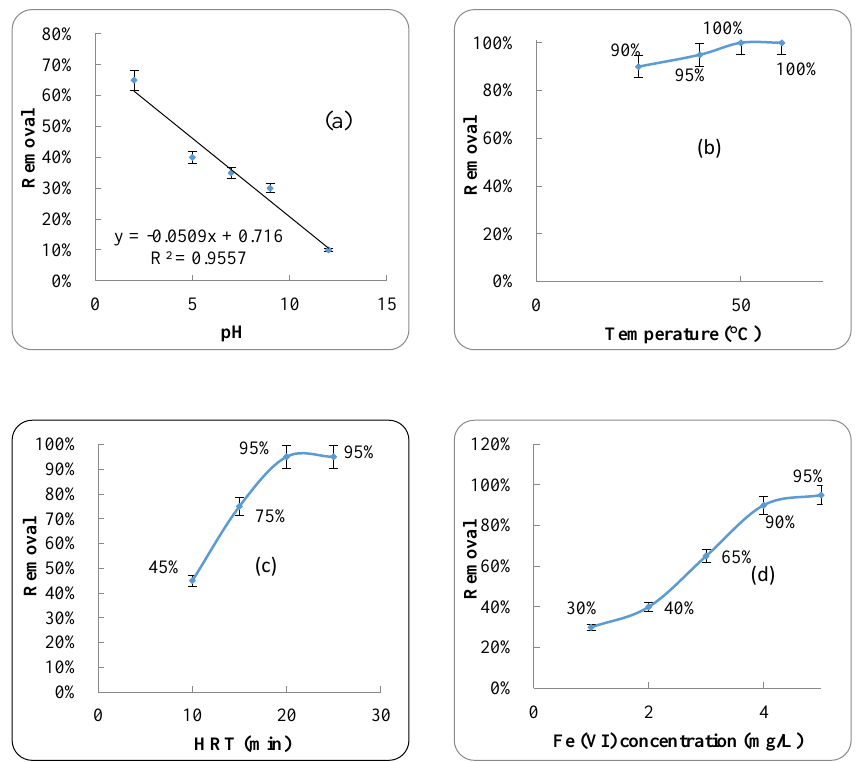
Figure 6. Antibiotic removal efficiency by Fe (VI); ( a ) The effect of pH; ( b ) The effect of temperature; ( c ) The effect of HRT; and ( d ) The effect of Fe(VI) concentration.